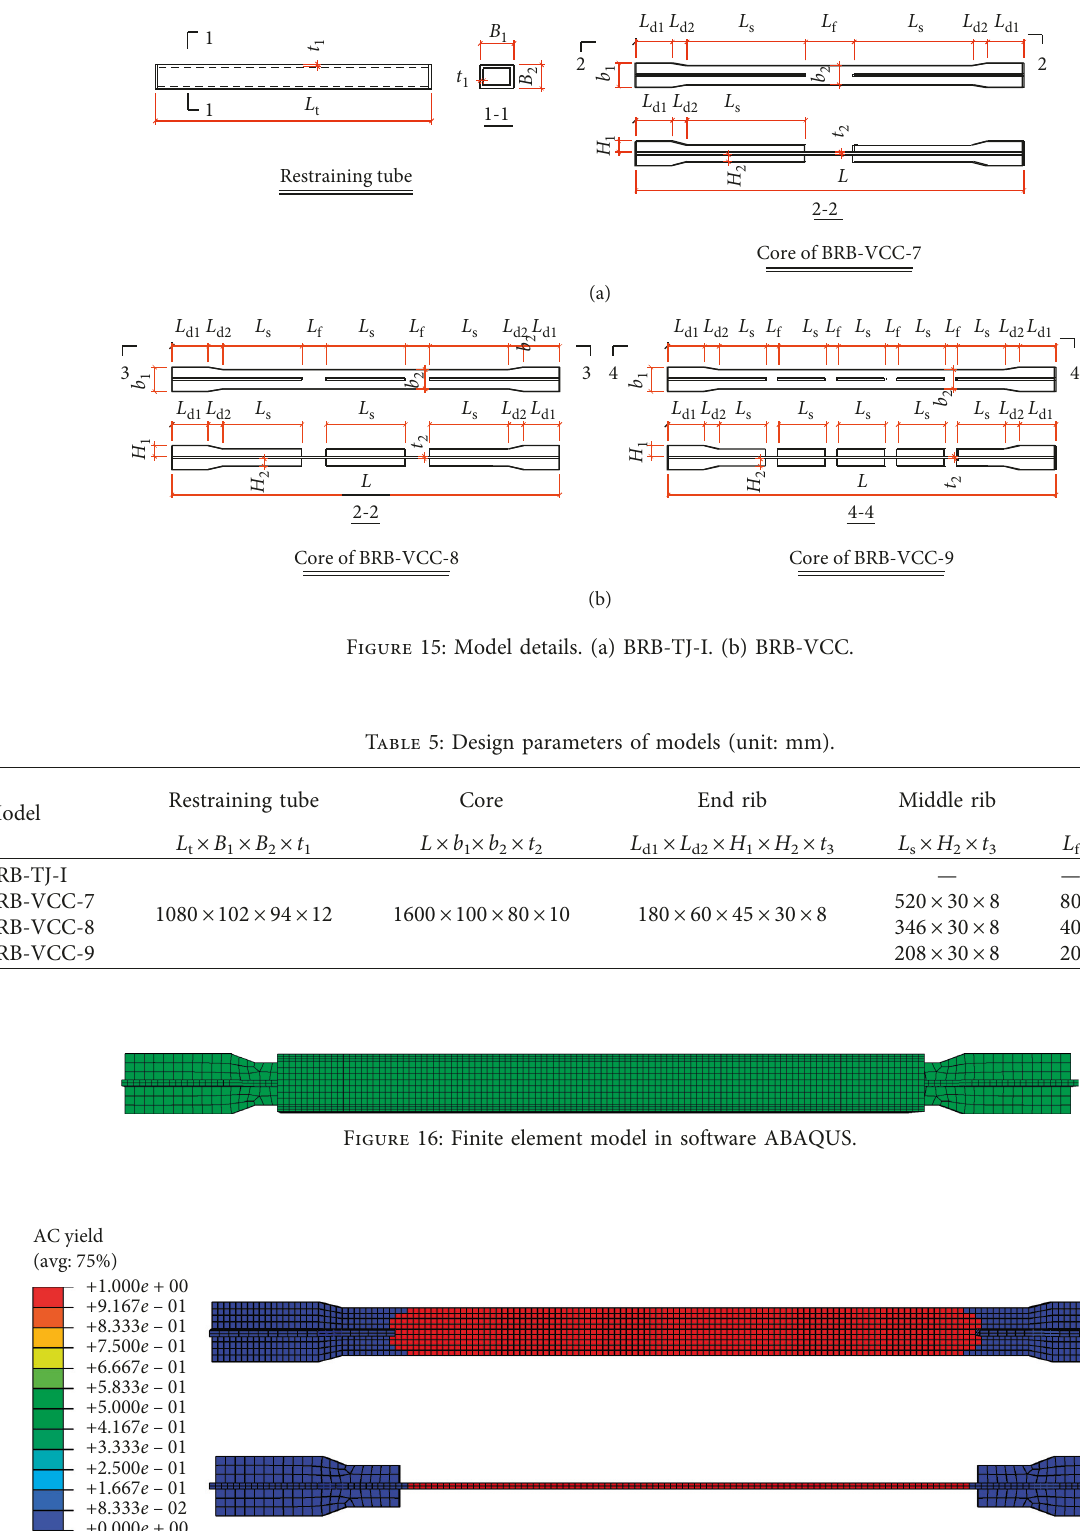
� 195.6kN). Note: AC YIELD is 1.0 in the plastic region and is 0 in the elastic